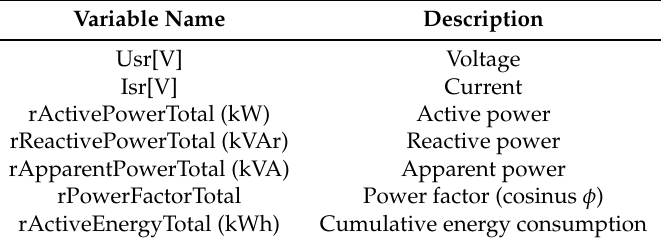
Table 1. Signals obtained from the on-board system.